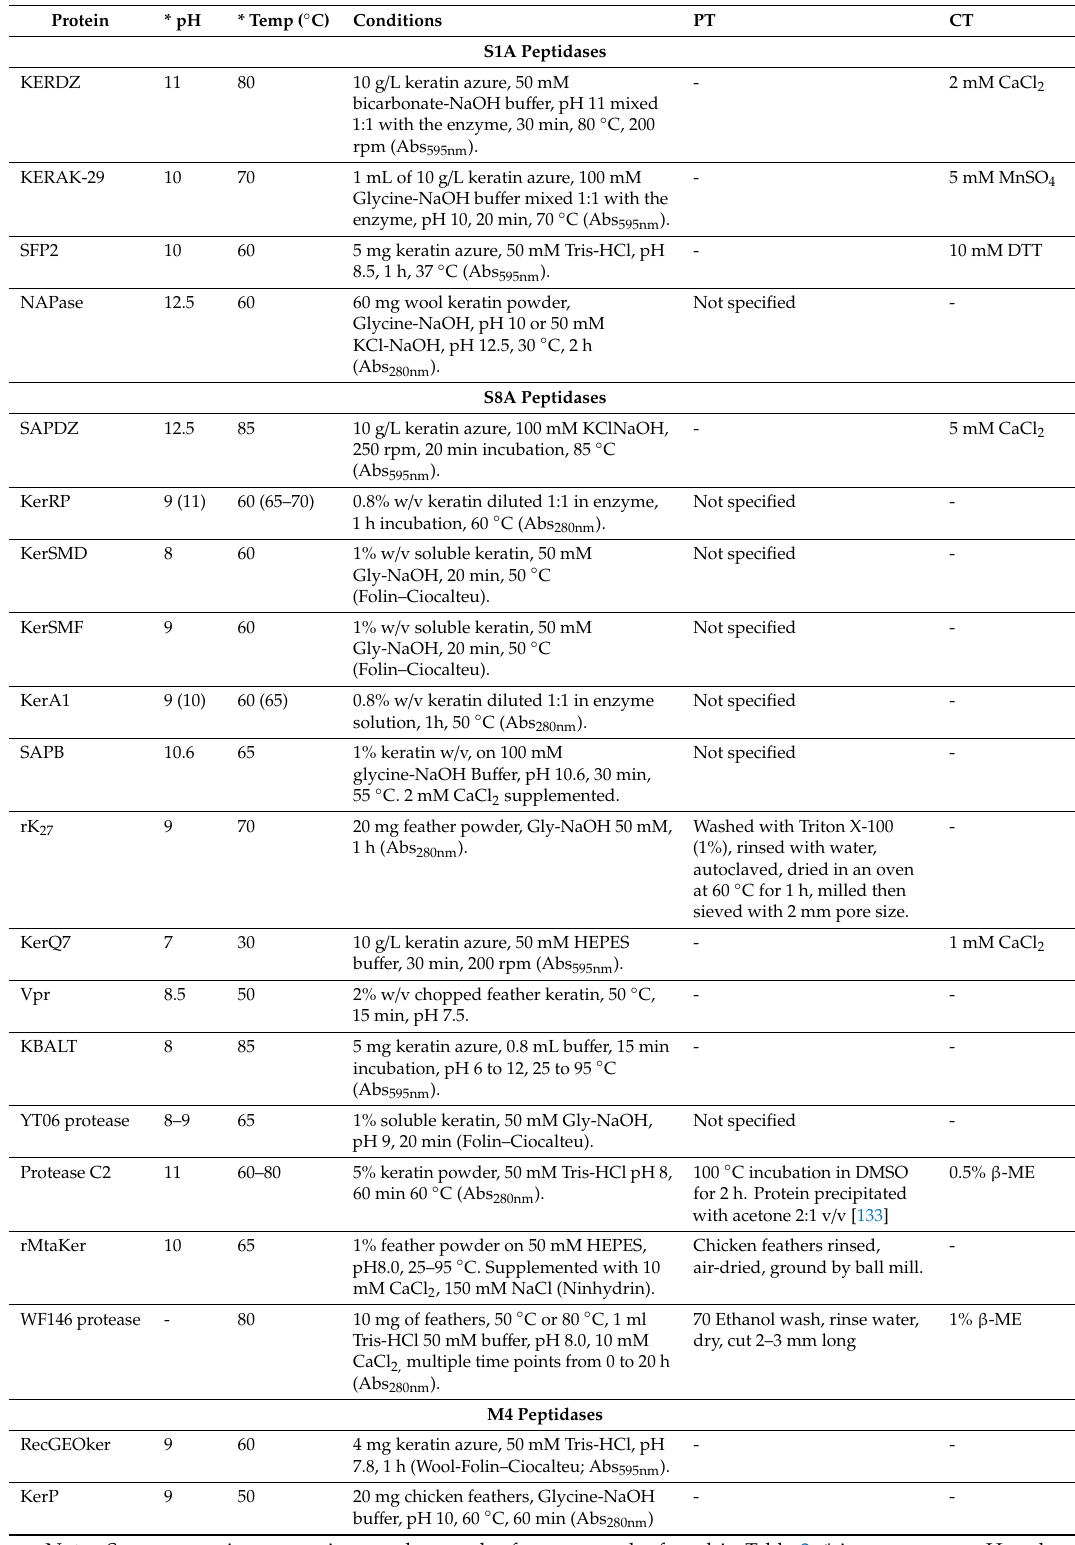
Table 4. Keratinase pH and temperature optimums of the selected S1, S8 and M4 keratinases with associated assay conditions. See text for further details of the